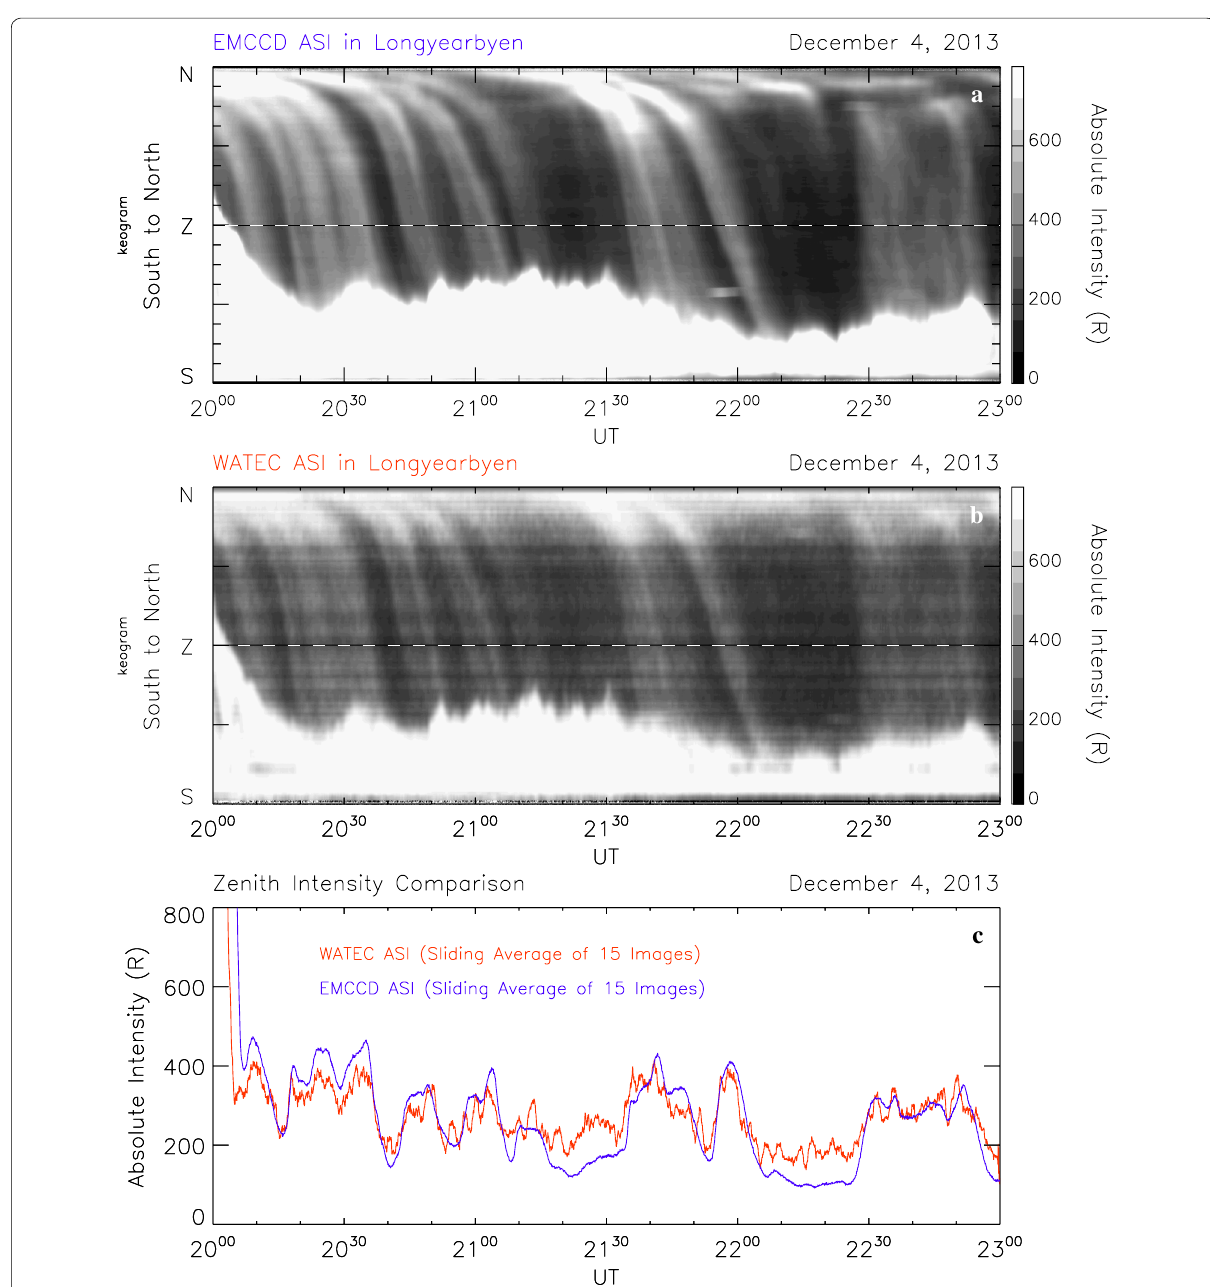
Fig. 4 Comparison of the WATEC ASI and EMCCD ASI, a time-series of the south-to-north cross-section of the absolute optical intensity of 630.0 nm airglow from the EMCCD ASI for a 3-h interval from 20:00 to 23:00 UT on December 4, 2013, b time-series of the south-to-north cross-section of the absolute optical intensity of 630.0 nm airglow from the WATEC ASI, and c time-series of the zenith intensity from the EMCCD (blue) and WATEC (red)